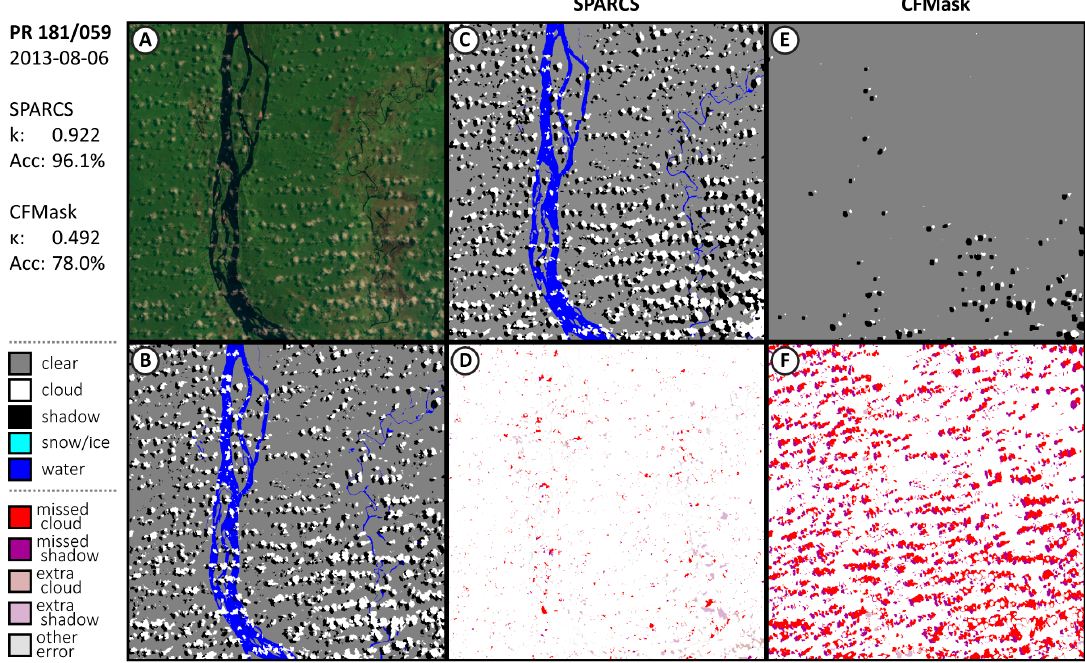
Figure A5. Results for validation test image PR 181/059, with false color image used during interpretation (A), the manually labeled interpretation (B), generated masks from SPARCS (C) and CFMask (E), and respective spatial distribution of errors (D, F).